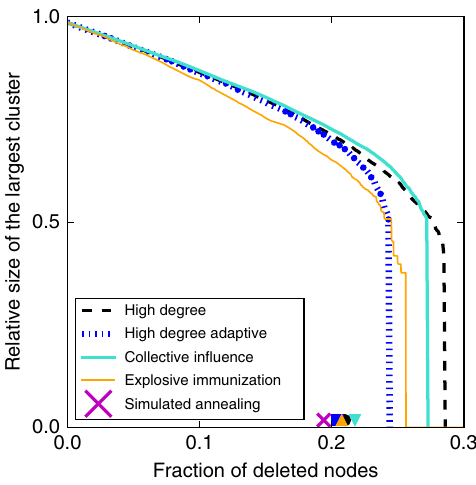
Fig. 1 Performance of different algorithms aimed at solving the optimal percolation problem. We consider a multiplex network with N = 10,000 nodes. The multiplex is composed of two network layers generated independently according to the Erdös − Rényi model with average degree 〈 k 〉 = 5. Each curve represents the relative size of the GMCC as a function of the relative number of nodes inserted in the set of SNs, thus removed from the multiplex. Colored markers indicate the effective fraction of nodes left in the set of SNs after a greedy post-processing technique is applied to the set found by the corresponding algorithm. The purple cross identi fi es instead the size of the set of SNs found through Simulated Annealing optimization. Please note that the ordinate value of the markers has no meaning; in all cases, the relative size of the largest cluster is smaller than N 1/2 . Details on the implementation of the various algorithms are